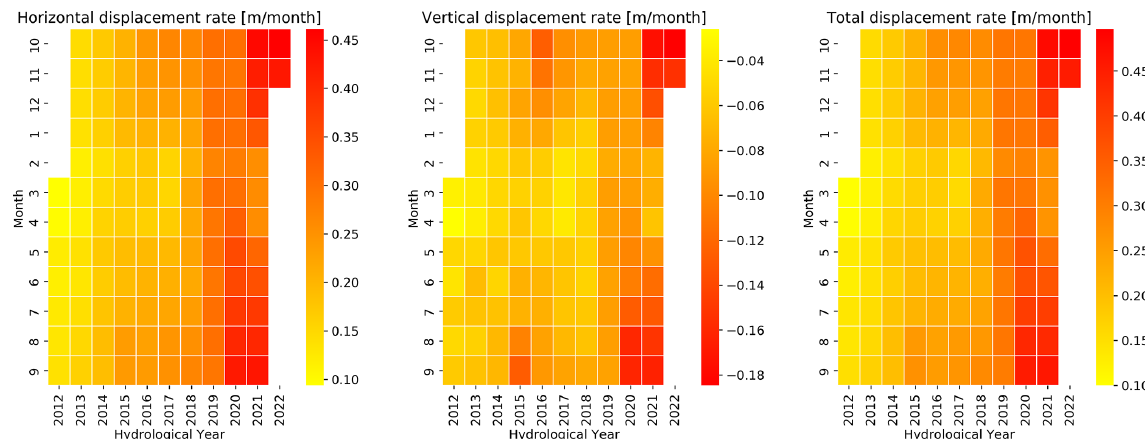
Figure A4. Station BH13 on the Breithorn/Bielzug rock glacier above Herbriggen; VS exhibits a steady acceleration downslope.